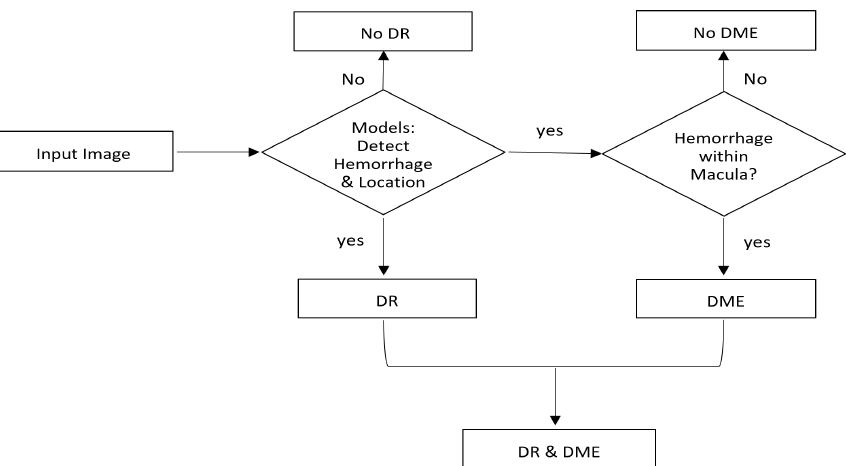
Figure 3. The step-by-step process of detecting hemorrhages and locating DME/DR with Faster R-CNN (R50-FPN) and Mask R-CNN (R50-FPN)